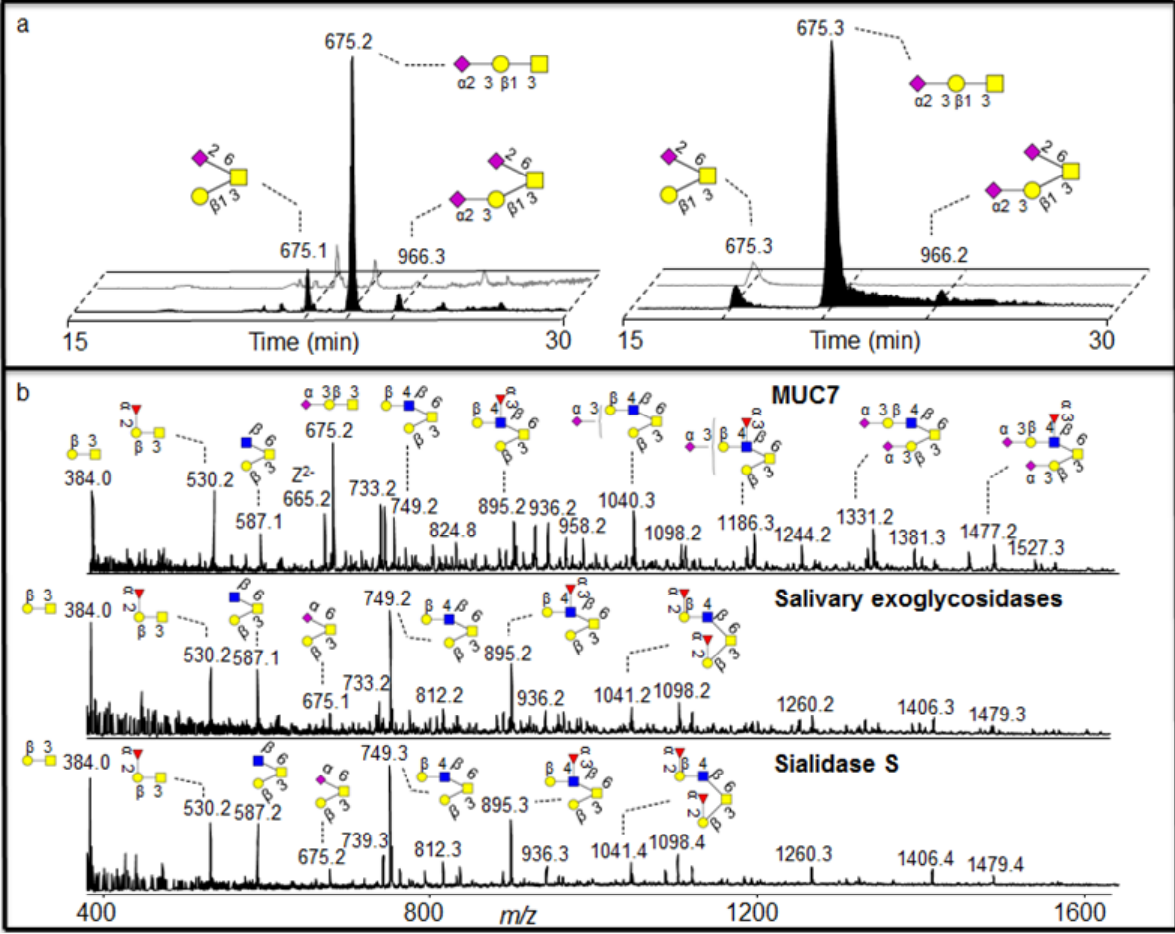
Figure 5. Linkage specific sialidase activity of saliva. (a) SIC of m/z 675 and 966 before (front) and after (back) incubation with saliva (left) and sialidase S (right) showing linkage specific sialidase activity of saliva. (b) Negative ion MS profile of MUC7 oligosaccharides before and after treatment with saliva and sialidase S. For explanation of symbols, see legend in Table